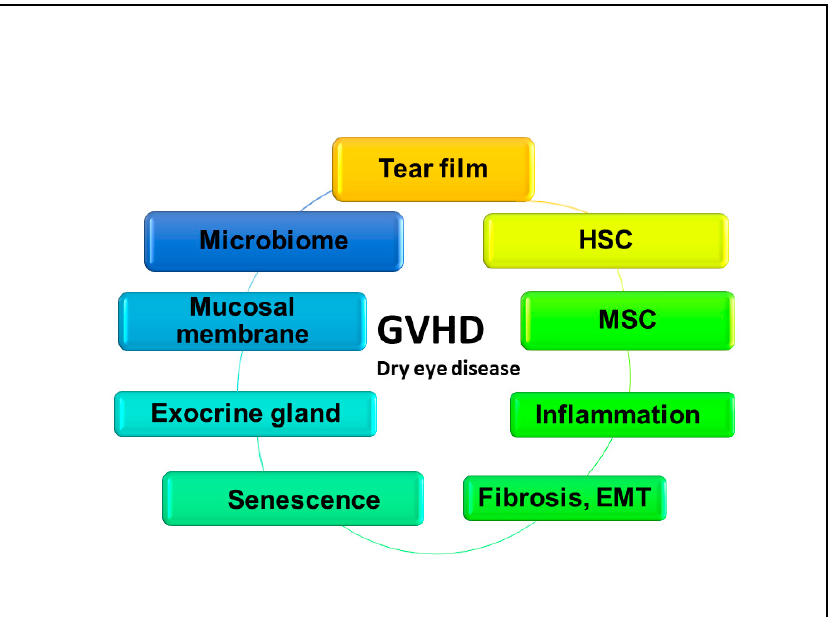
Figure 1. A variety of biological areas orchestrate in ocular GVHD, dry eye disease, which are representative of a manifestation of ocular GVHD and are related to various aspects of the study area including the tear film, microbiome, mucosal and exocrine gland immunity, stem cell biology on HSC or MSCs, acute and chronic inflammation, pathogenic fibrosis including fibroblasts origin, and stress-induced senescence. Those pathways are connected timely and spatially to each other and the development of ocular GVHD, MSC; mesenchymal stem cells, HSC; hematopoietic stem cells, EMT; epithelial mesenchymal transition.